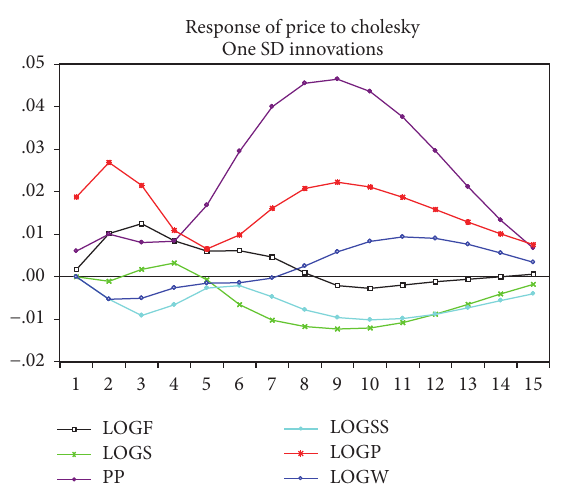
Figure 2: Responses of the coal price to influencing